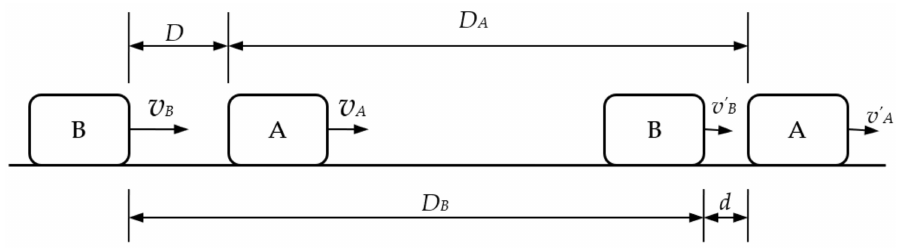
Figure 1. Automobiles in a braking